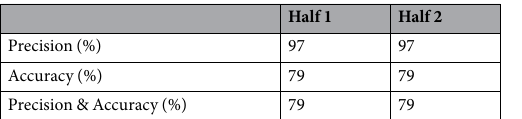
Table 1. Percentage of particles that align with precision, accuracy and both precision and accuracy for each half of the β -galactosidase